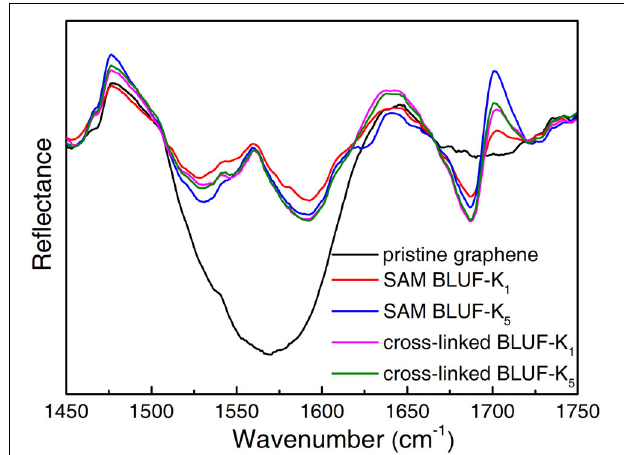
FIGURE 5 | FT-IR reflectance spectra of pristine graphene (black) and after modification with BLUF through PBA.